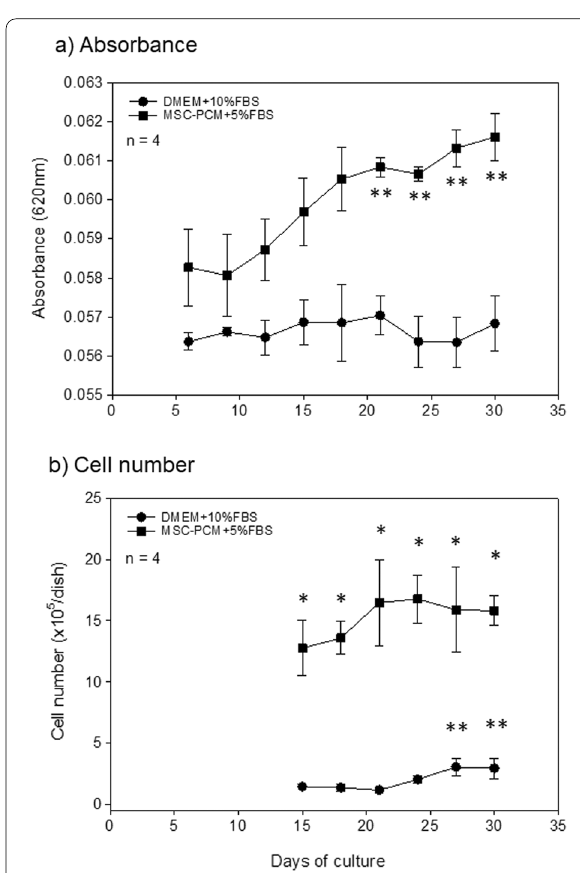
Fig. 6 Time-course changes in a absorbance values and b cell numbers. n 4. * P < 0.05 vs. DMEM 10%FBS at the same timepoints. = + ** P < 0.05 vs. the same culture conditions at 6 days (absorbance) or 15 days (cell